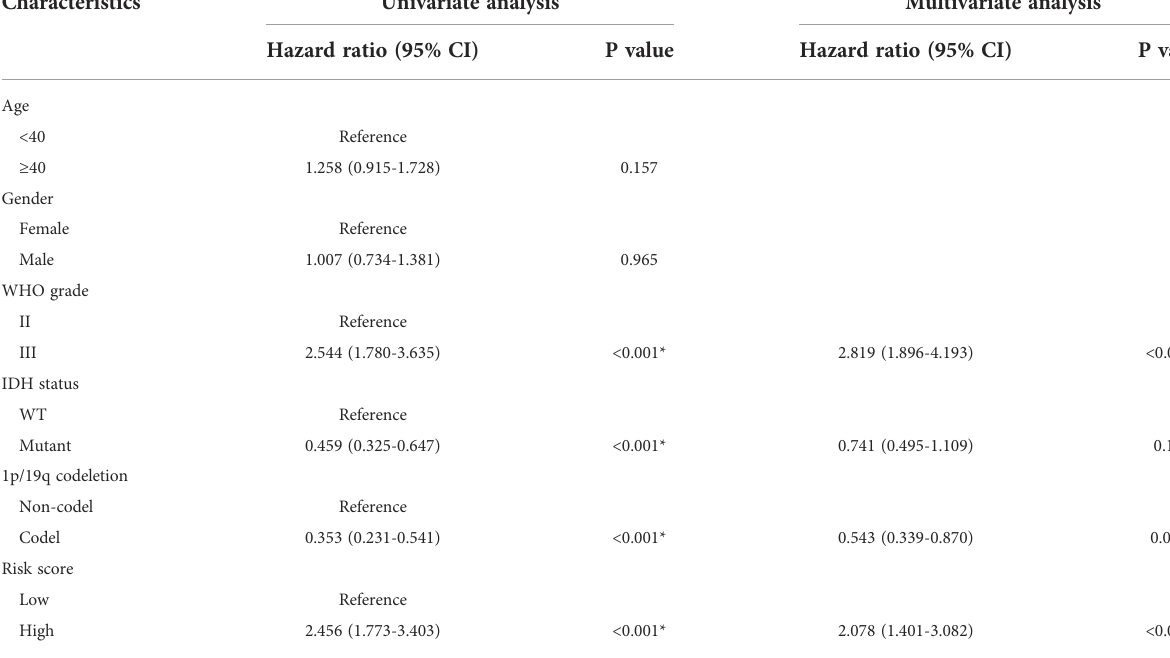
TABLE 4 Univariate and multivariate Cox regression analyses in CGGA sequencing